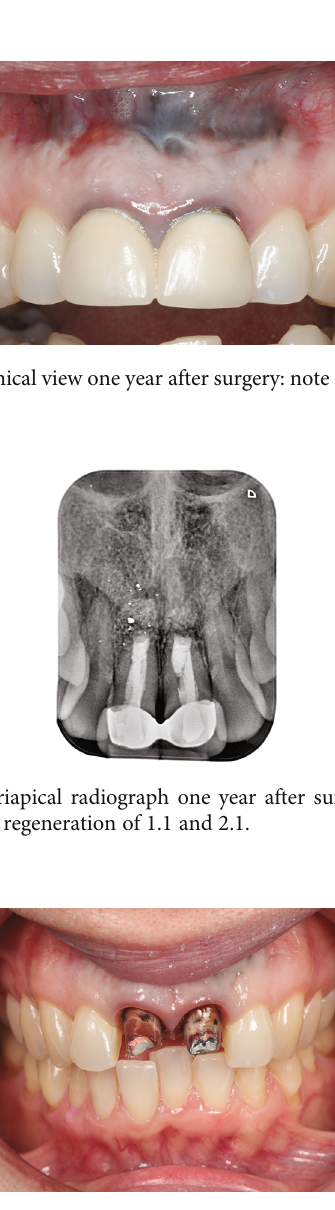
Figure 22: Periapical radiograph 6 months after surgery: correct progression of bone healing of the defect is observed.